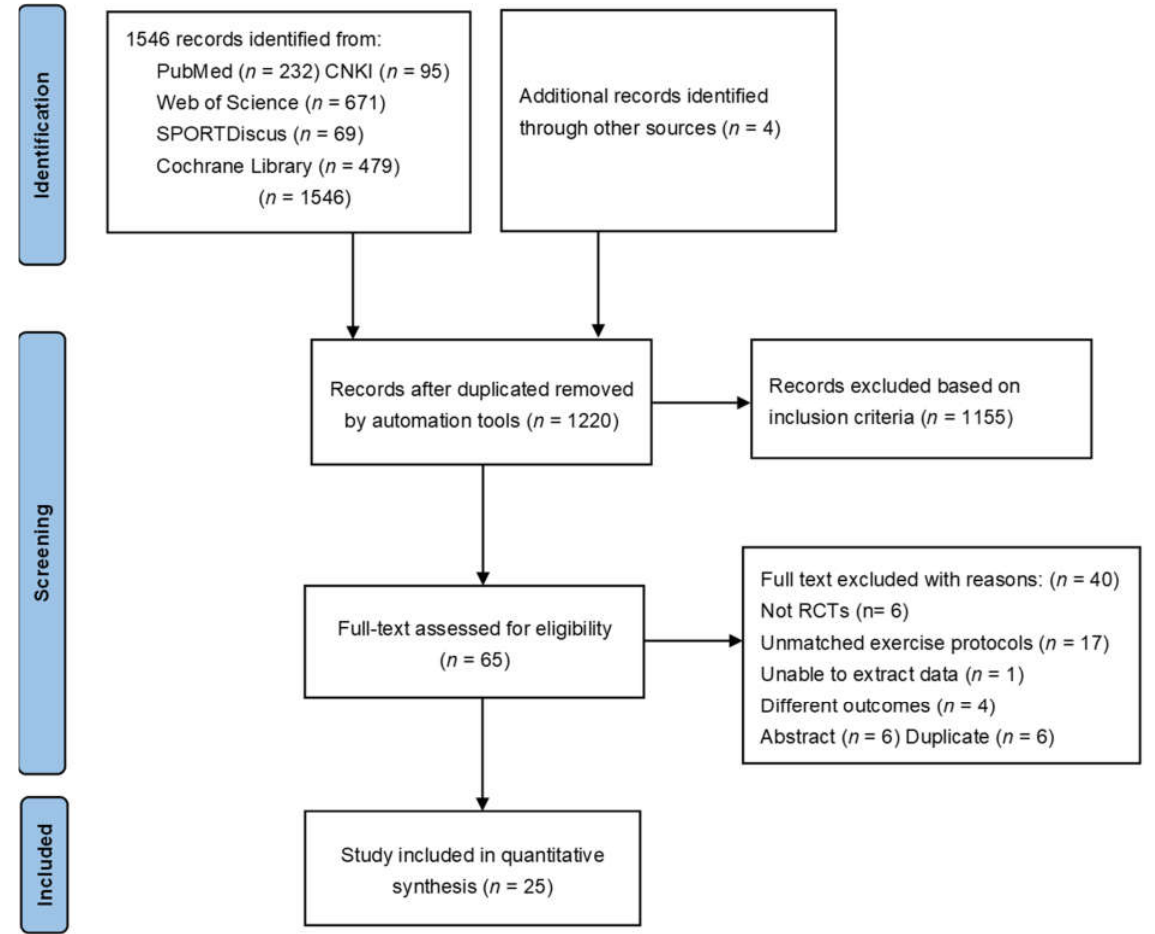
Figure 1. PRISMA flow chart.